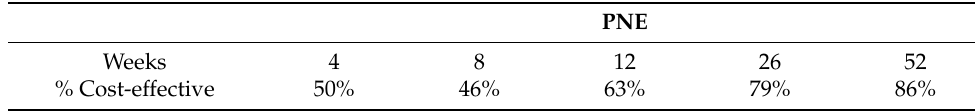
Table 4. Variation of cost-effective ratio during the study.